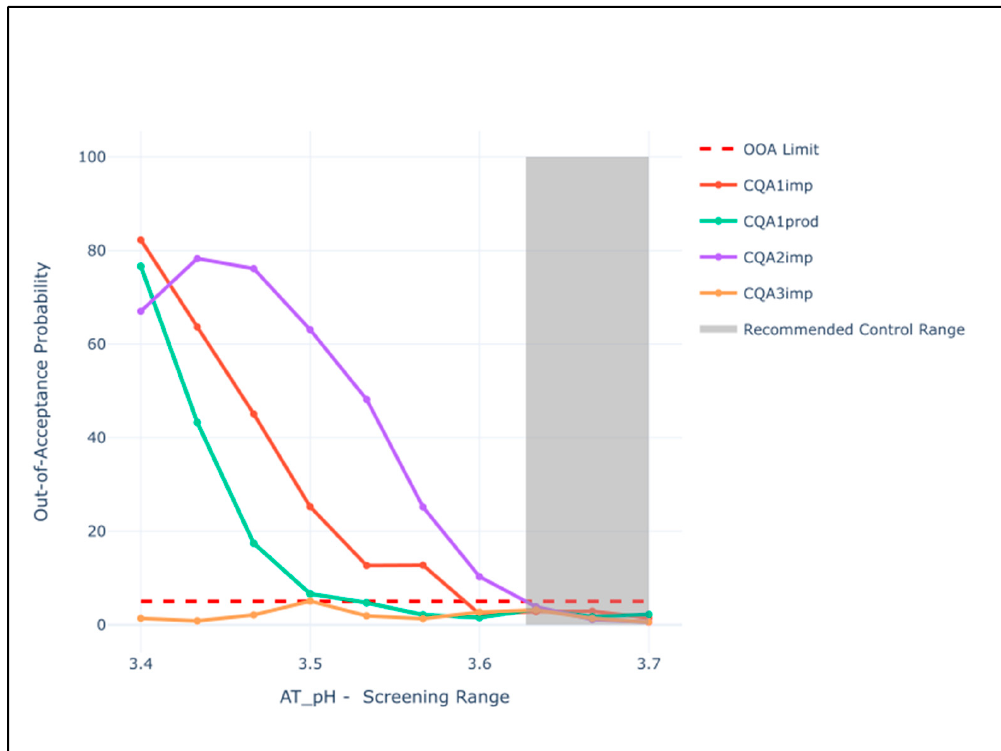
Figure 6. PSA plot for AT_pH. The impact of the 4 CQAs is depicted as a behavior across the screening range. The proposed control range is highlighted in grey. Note that AT is the second unit operation in process order, but the plots depict the impact on DS results. Table 3. Summary overview of automated results for PAR setting by PSA.